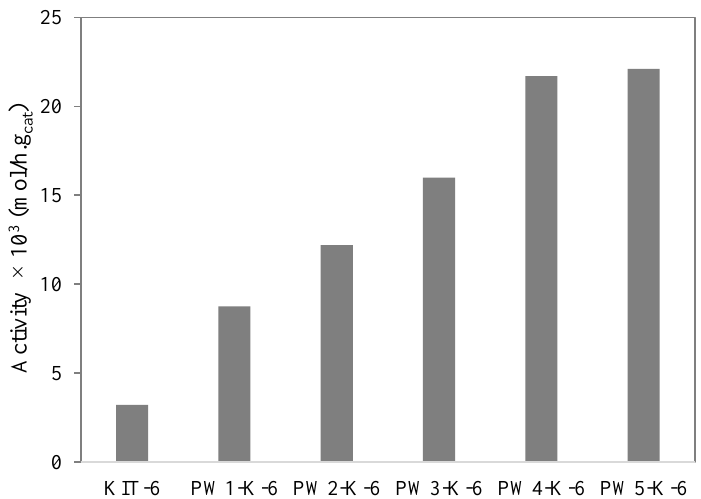
Figure 7. Initial activity of KIT-6 and HPW-K-6 in the acetalization of glycerol with citral. Figure 8 exhibits the conversion versus time (h). The glycerol conversion (%) was 18% (KIT-6), 46% (PW1-K-6), 60% (PW2-K-2), 80% (PW3-K-6), 89% (PW4-K-6), and 86% (PW5- K-6), after 5 h of reaction.